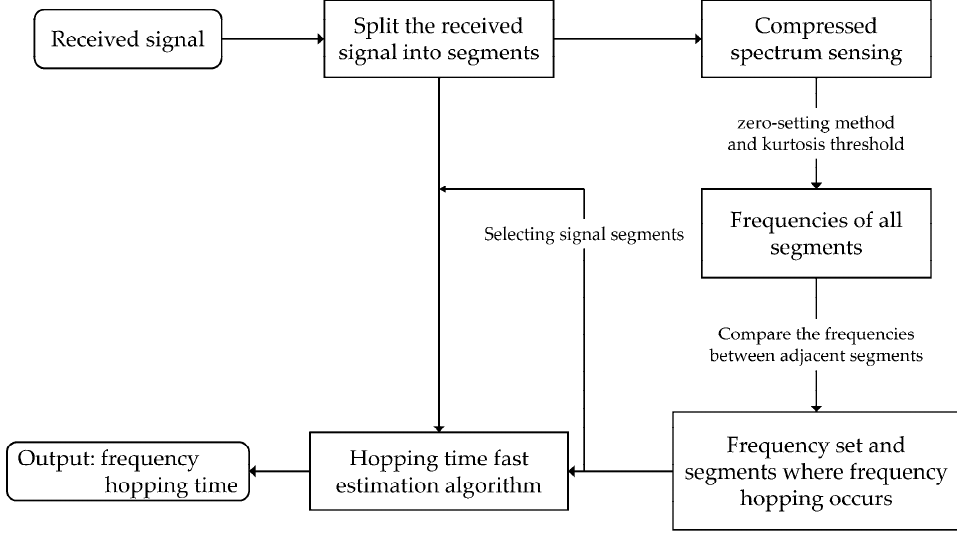
Figure 6. Flow chart of the CSML algorithm.